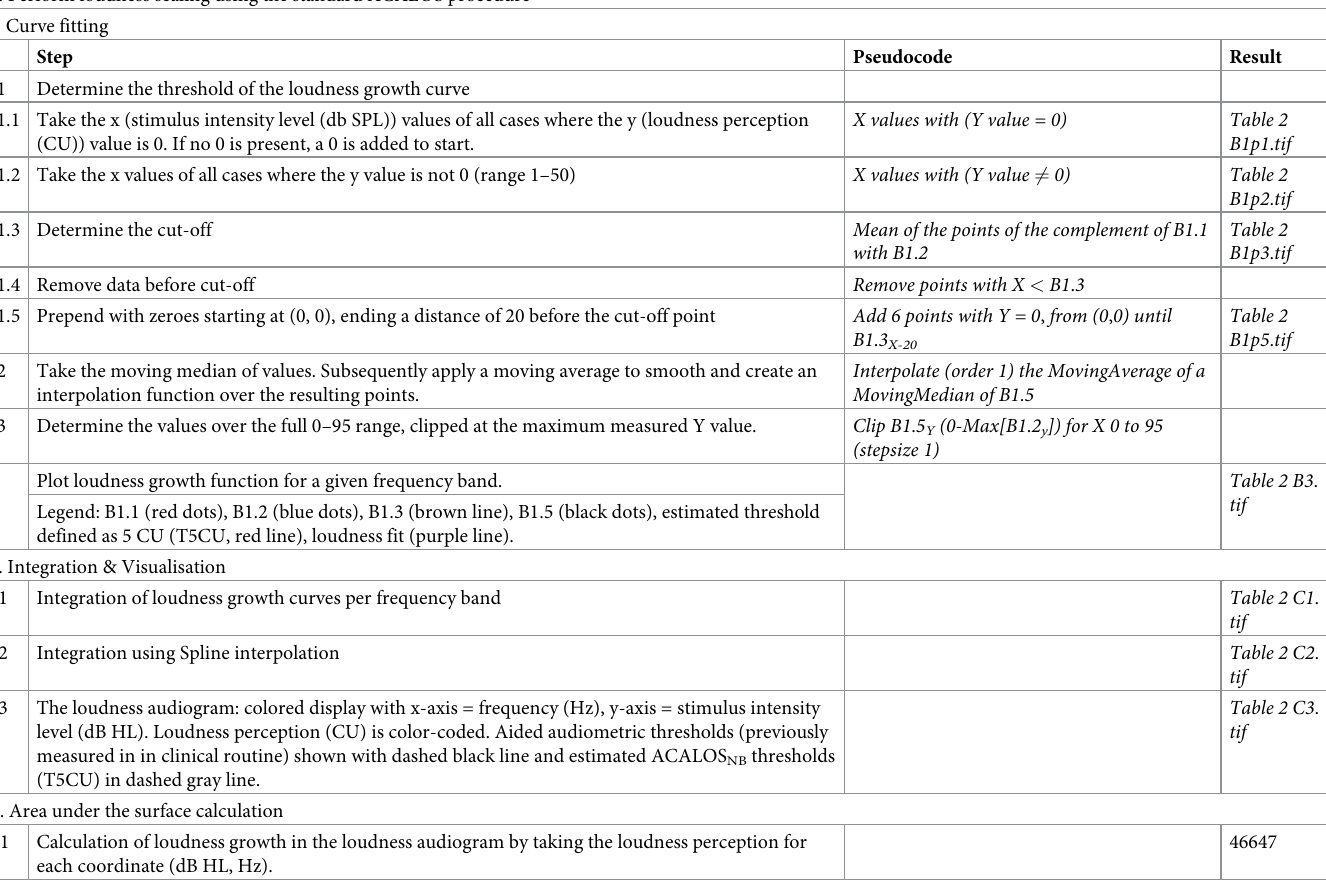
Table 2. Algorithm for extending the audiogram with loudness